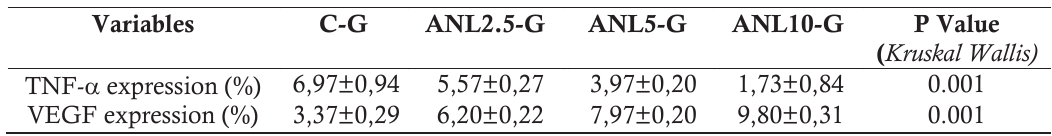
Table 1. Mean Expression (± SD) of TNF- α and VEGF Variables